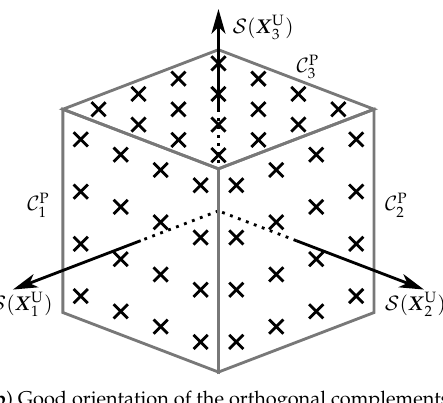
Figure 7. Three-dimensional graphical representation of the effect of the orthogonal complements orientation and the coherent code shape. A USTM of three elements is used to construct three PSAMs, which elements are surrounded by quadrilaterals. (coherent code: ‘ × ’